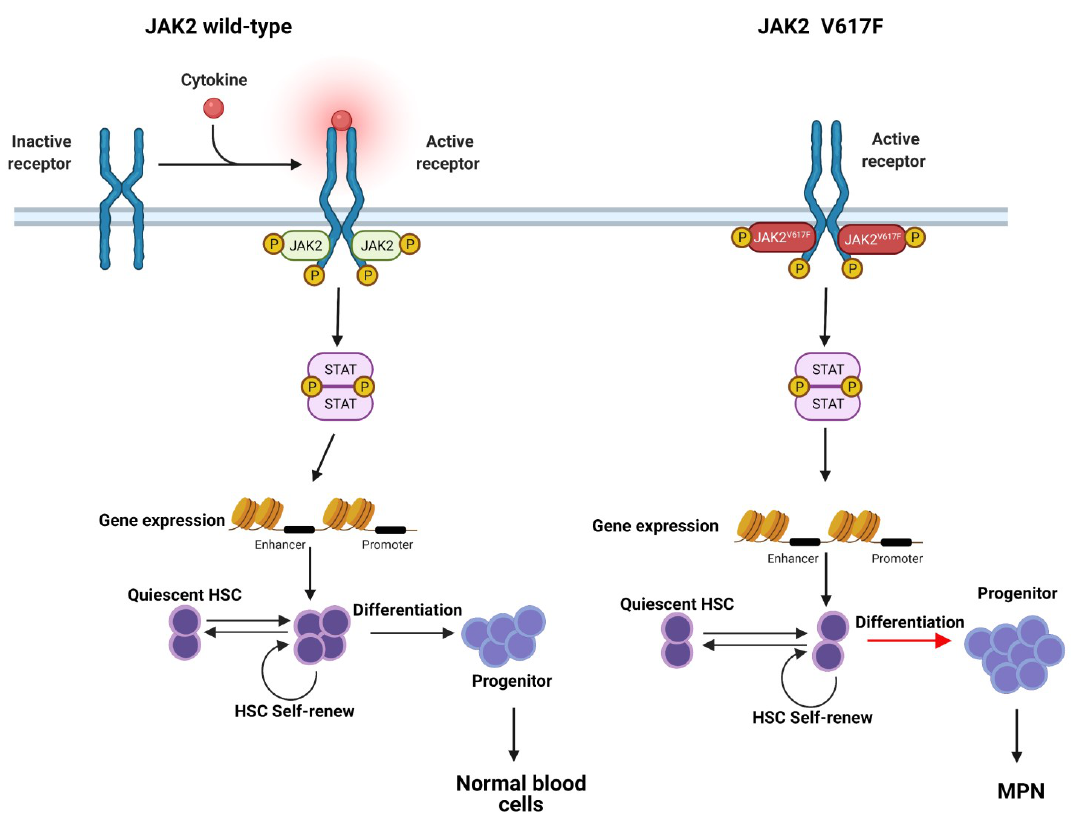
Figure 2. Typical and JAK2V617F induced dysregulated JAK2-STAT signaling. Normal JAK-STAT signaling is mediated by cytokines and growth factors, for instance, EPO and TPO, which maintain an ordered balance of cell proliferation and differentiation by self-renewal in HSC cell pool and are essential for normal blood cell formation (left panel). The JAK2V617F mutation causes JAK2 to be more sensitive to cytokines and consistently activates the JAK-STAT pathway. The over-activation of JAK2-STAT signaling alters the critical cell fate and leads to more progenitor cell development and further progression to MPN (right panel).